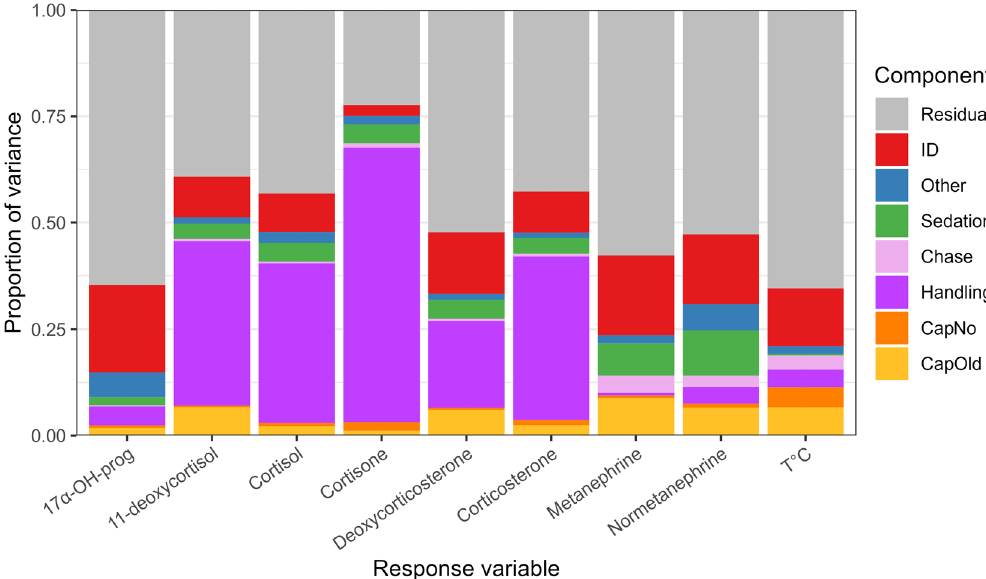
Figure 2. Proportion of the variance in each measured variable describing the acute stress response during capture in female Svalbard reindeer. The individual hormones and rectal temperature are explained by different groups of explanatory variables as measured with a hierarchical multivariate model. ‘ID’ refers to the repeatable individual component (i.e.: individual difference in baseline levels). Explanatory variables were grouped into other variables (blue; year and age), sedation (green), chase duration (pink), handling duration (purple), and number of captures in the current and past years (‘CapNo’, light orange, and ‘CapOld’, dark orange,